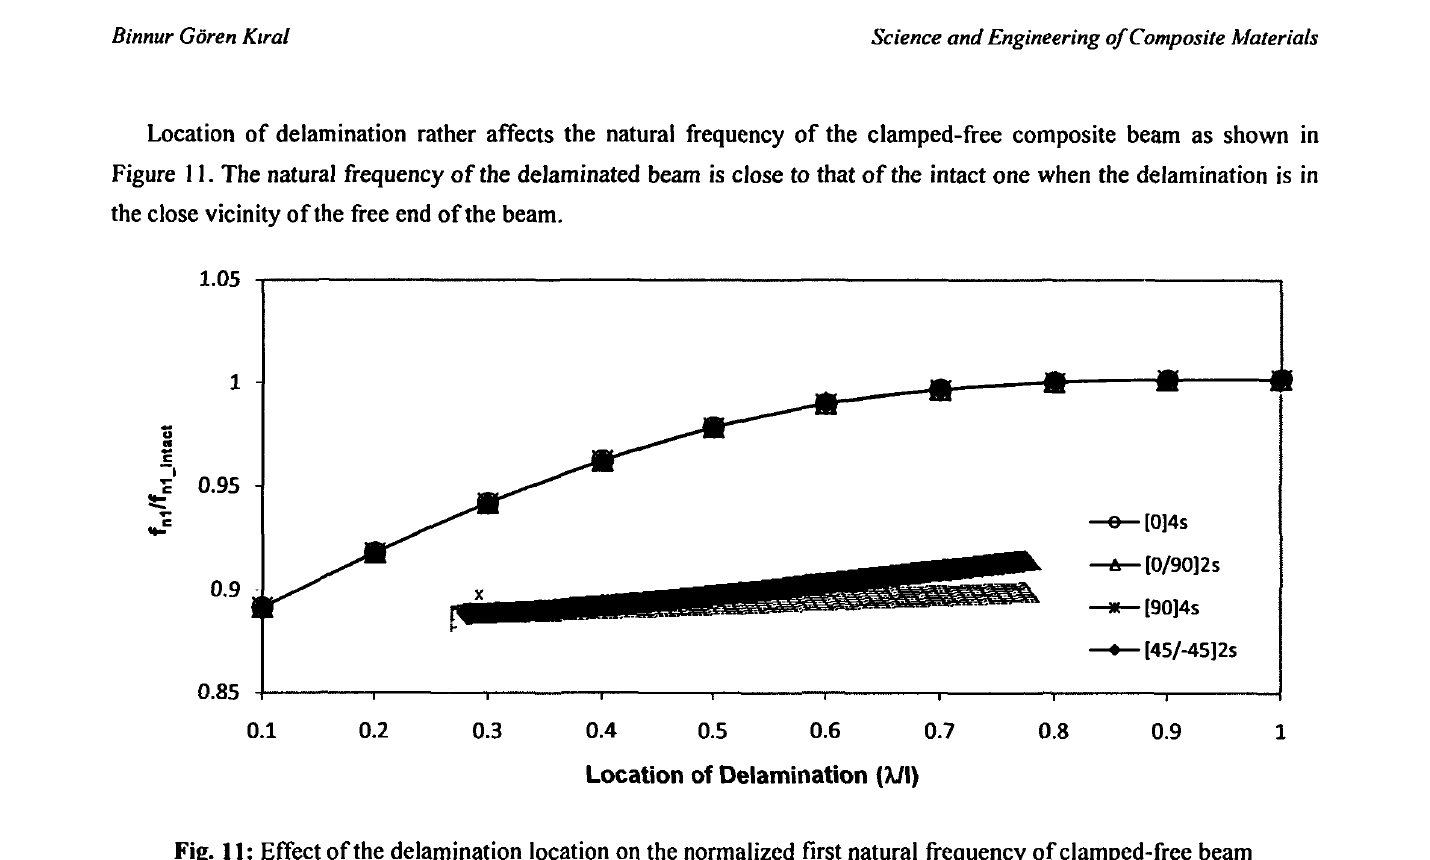
Fig. 11: Effect of the delamination location on the normalized first natural frequency of clamped-free beam